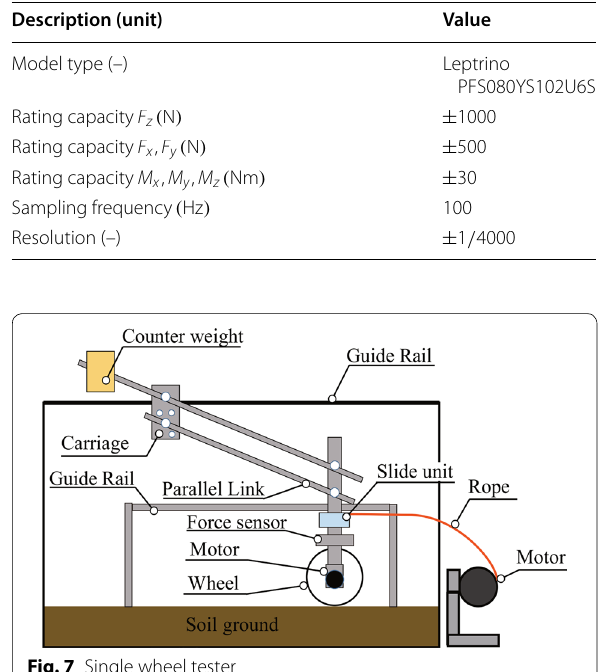
Table 5 Specification of force